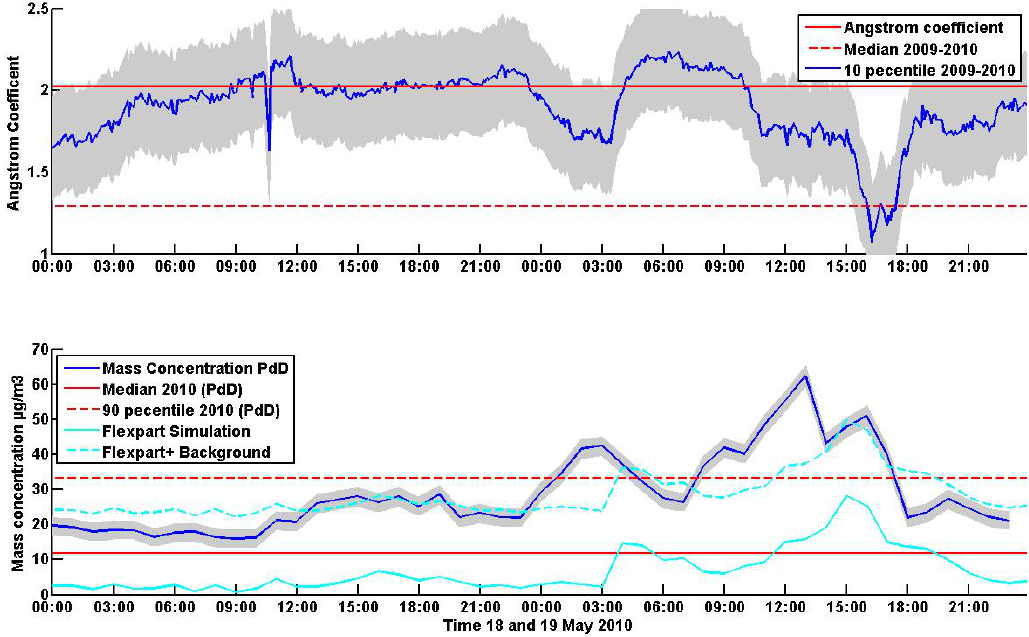
Fig. 3. Top panel: ˚Angstr¨om coefficient for the 18 and 19 May. The continuous red line indicates the median observed in 2009 and 2010 and the dotted line represents the 10th percentile. Bottom panel: mass concentration in µgm − 3 measured by the TEOM in blue and simulated by FLEXPART at the Puy de Dˆome height for the same date. The continuous red line indicates the median measured in 2010 and the dotted line represents the 90th percentile. The dotted cyan line represents the FLEXPART simulated mass plus the background measured before the volcanic event.